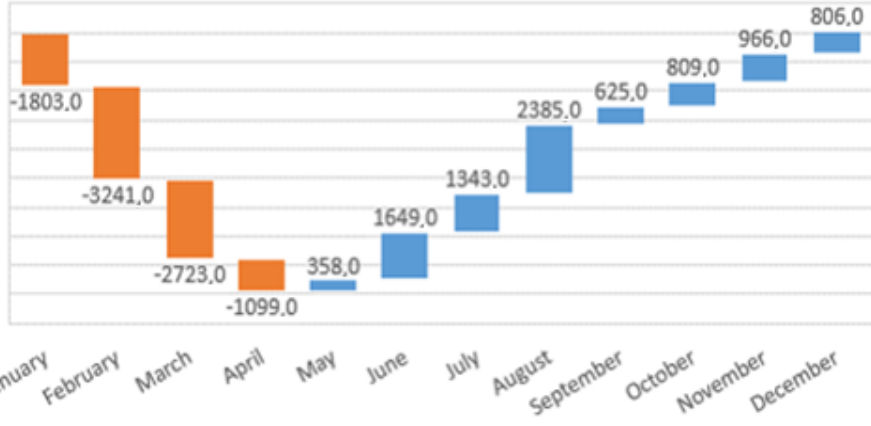
Figure 12. Annual production purchases profile.